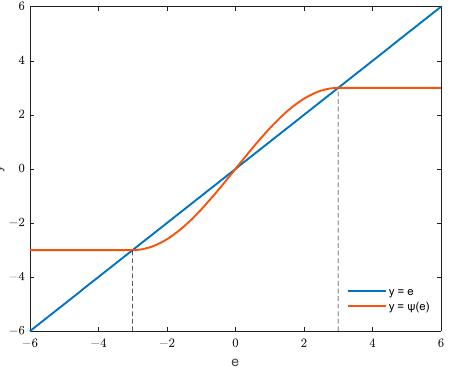
Figure 10. The function curve of 𝜓(𝑒) when 𝛼 = 3 .